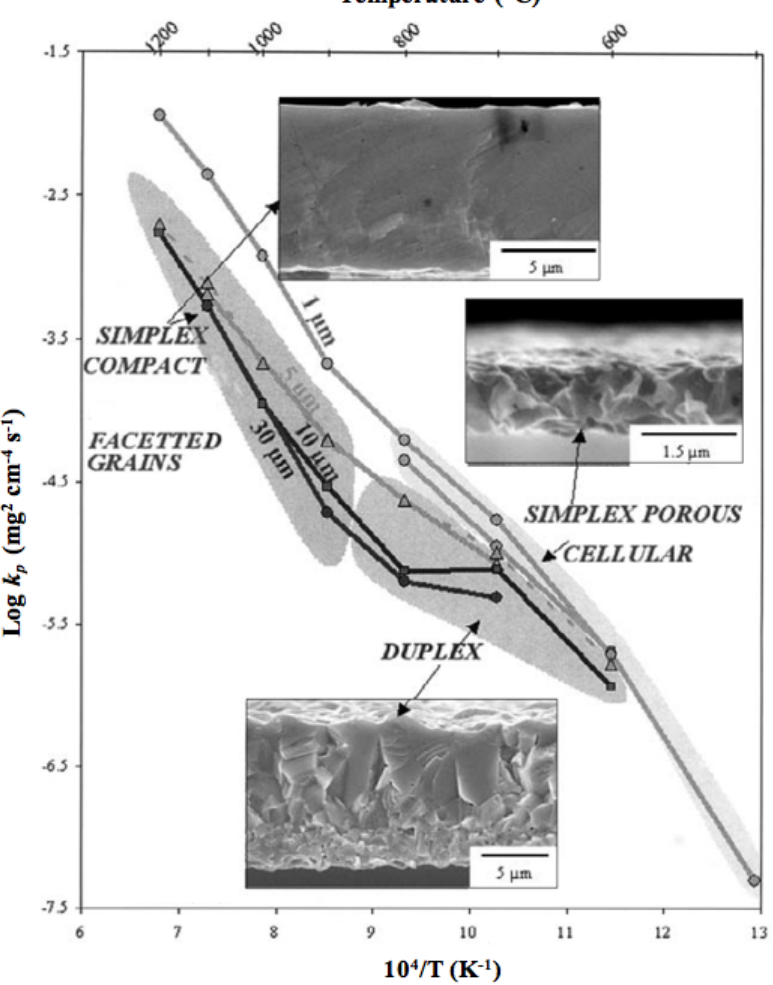
Figure 2. Arrhenius plot of parabolic rate constant k temperature and scale thickness indicating NiO scale morphologies and microstructures